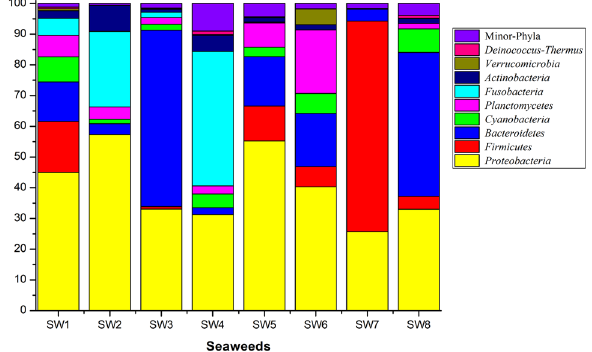
Figure 1. Relative abundance of sequences representing bacterial phyla constituting epiphytic bacterial communities on different seaweed